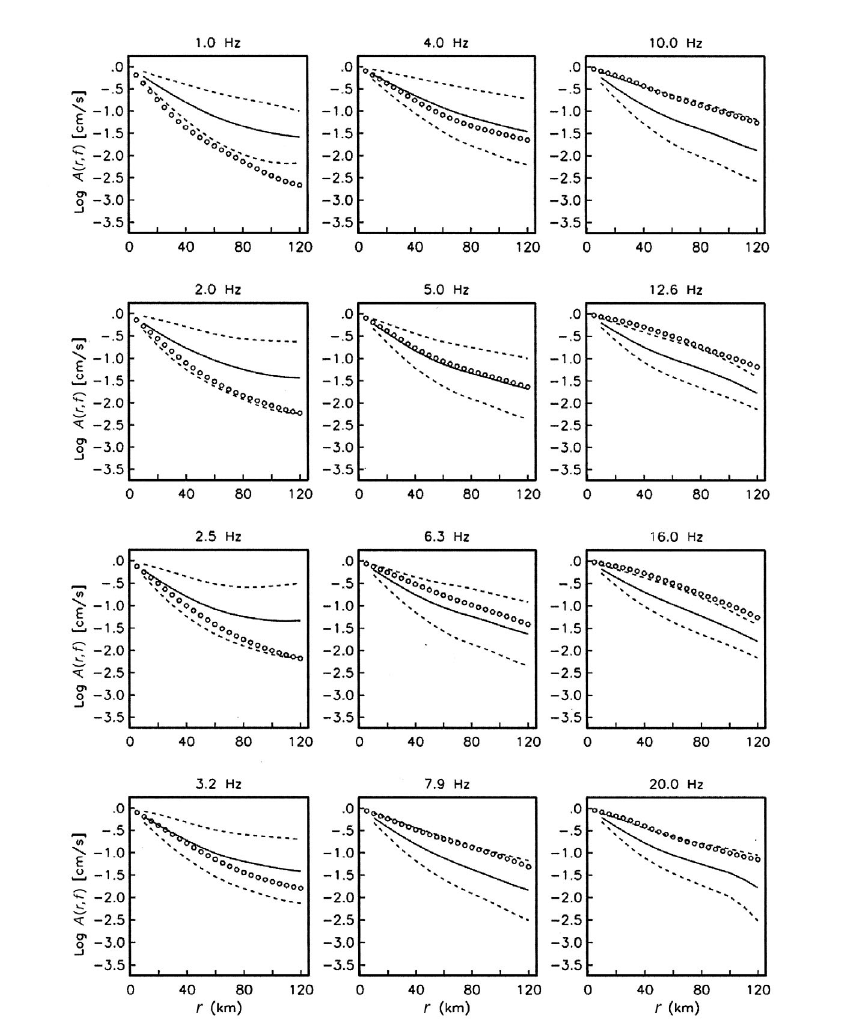
Fig. 6. Average NAF (solid lines) and ± 1 standard deviation (dashed lines) obtained by Castro et al. (1999) from different regions of Italy and the attenuation functions obtained for Southern Italy (this